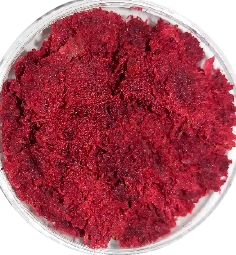
Figure 1. Appearance of beetroot byproduct recovered from the process of obtaining beetroot juice by liquefying.